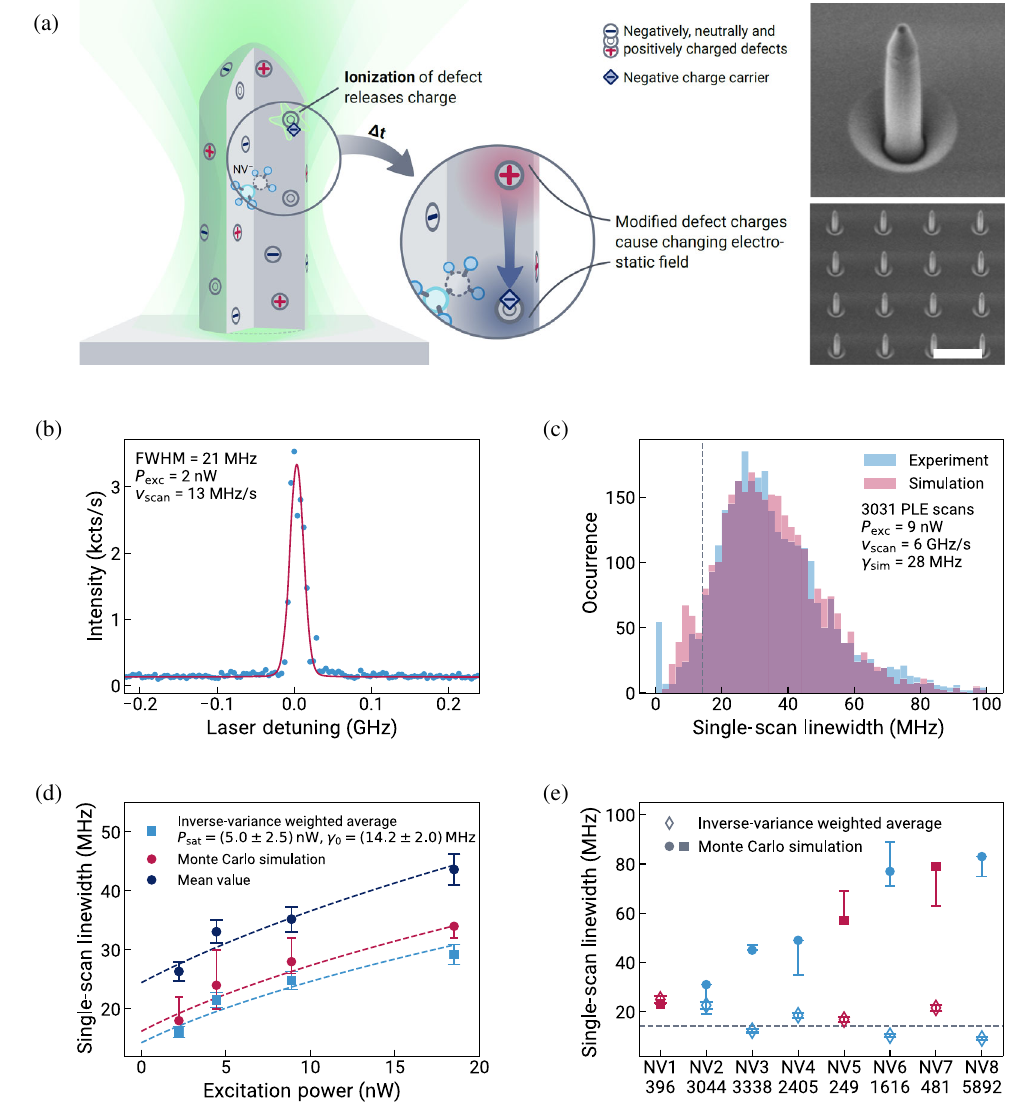
FIG. 1. Nanostructure and single-scan linewidth. (a) Schematic sketch of a NV incorporated in a nanopillar. Green laser irradiation causes ionization of present surface and bulk defects; i.e., charges are released and move within the lattice, for example, to other defects that act as charge traps. This dynamic induces fluctuations of the electrostatic environment of the NV and leads to spectral diffusion of the NV ZPL. Insets: scanning electron microscopy images of a single nanopillar with a radius of 125 nm and a height of 1 . 6 μ m (top) and an array of identical nanopillars (bottom). The scale bar corresponds to a dimension of 2 μ m. (b) Single PLE scan described by a Voigt profile. The exemplarily selected spectrum shows a linewidth close to the lifetime limit maintained for about one second. (c) Histogram presenting the occurrence of single-scan linewidth obtained from 3031 PLE scans. The measured data are simulated by a Monte Carlo approach. From the simulations, a power-broadened linewidth of 28 MHz is determined. The gray dashed line indicates the lifetime-limited linewidth of 14 MHz. (d) Single-scan linewidth as a function of excitation power at a scan speed of 6 GHz = s. The single-scan linewidths are evaluated using three methods. The data can be fitted by the function ffiffiffiffiffiffiffiffiffiffiffiffiffiffiffiffiffiffiffiffiffi p 1 þ P=P γ ¼ γ describing laser-induced power broadening of the linewidth. For the Monte Carlo simulation, the saturation 0 sat 5 . 4 (cid:2) 2 . 2 Þ nW and γ 16 . 2 (cid:2) 1 . 8 Þ MHz, and for the mean value power and natural linewidth are determined as P 0 ; MC ¼ ð sat ; MC ¼ ð 8 . 1 (cid:2) 2 . 9 Þ nW and γ 24 . 4 (cid:2) 2 . 2 Þ MHz. (e) Plot summarizing the single-scan linewidths of eight single approach as P 0 ; MV ¼ ð sat ; MV ¼ ð NVs in different nanopillars from different sample regions (blue circles and red squares). The NVs are labeled with the number of PLE scans that were taken into account. The excitation power is 19 nW, and the scan speed is 50 GHz = s. In contrast to panel (d), we apply a 525 nm initialization pulse before every line scan. For the linewidth analysis, the Monte Carlo simulation (filled circles and squares) and inverse-variance weighting (empty diamonds) methods are used. The uncertainties of the single-scan linewidths determined by the Monte Carlo simulation are given by the 99% confidence interval. For this fast scan speed, the inverse-variance method is not valid